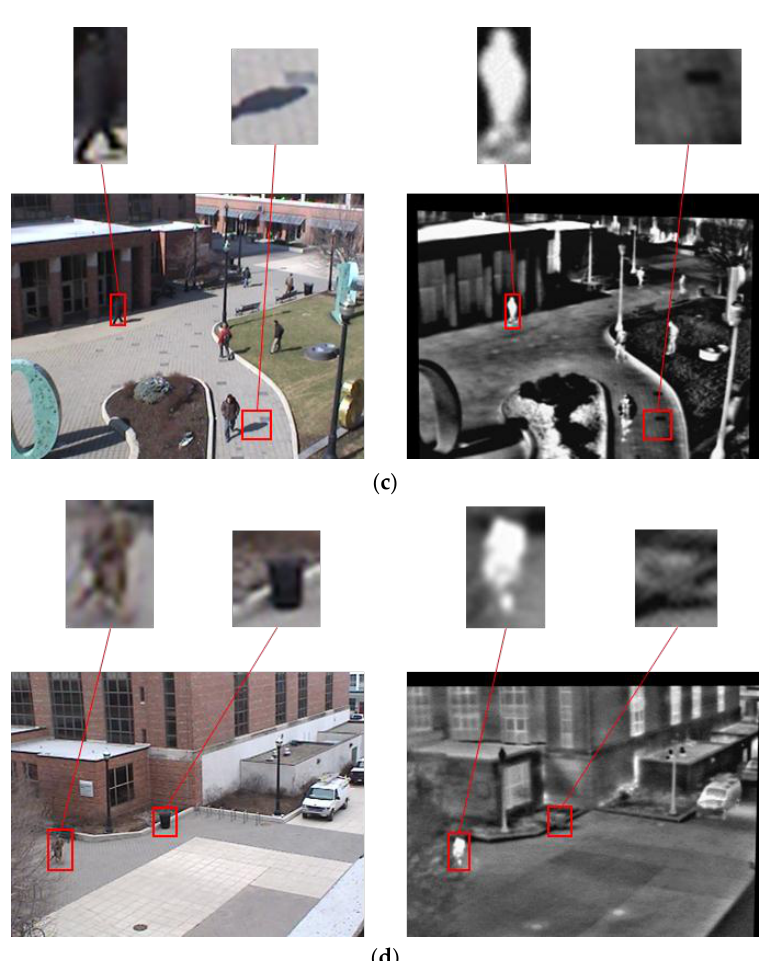
Figure 12. Examples of OSU color-thermal database. ( a ) Example 1, ( b ) example 2, ( c ) example 3, and ( d ) example 4. In ( a – d ), left and right images show the visible light and FIR light images, respectively. In ( a – d ), upper and lower images represent the candidates and original images, respectively.